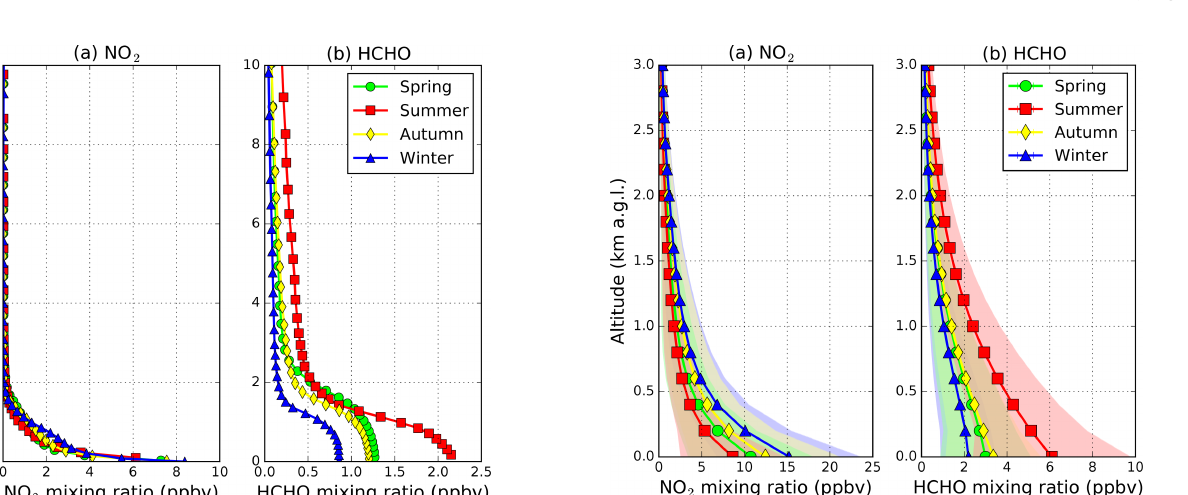
Figure 6. Seasonal average of (a) NO 2 and (b) HCHO a priori pro- files used in OMI retrieval. A priori profile of spring (March, April, May), summer (June, July and August), autumn (September, Octo- ber, November) and winter (January, February and December) are shown.